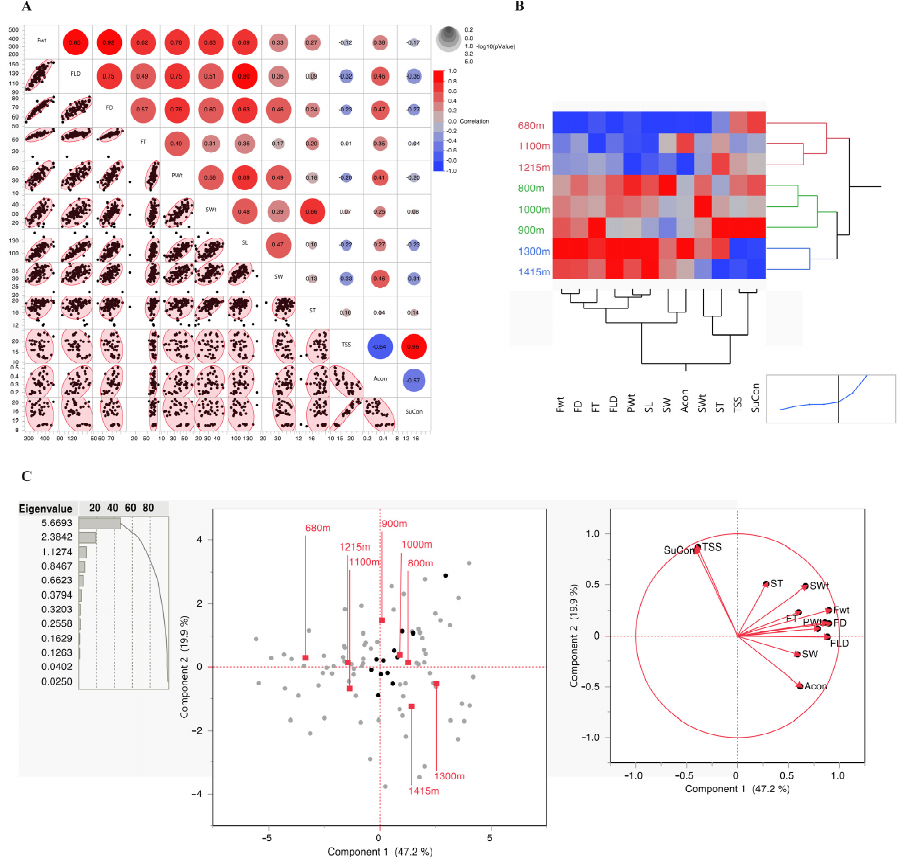
Figure 1. Multivariate analysis of phenotypic and quality traits: ( A ) Pearson’s correlation between all traits. Diagonal is labeled as traits, and on upper triangle shows the pairwise correlation between traits, and the lower triangle shows the distribution of each trait (values of the x axis and y axis are traits values according to which the distribution pattern was estimated); ( B ) Clustering based on phenotypic traits and altitude. The graph in the bottom right corner shows the number of significant clusters based on F -statistics; and ( C ) Principal component analysis depicting the distribution of traits and locations based on the first two components, PC1 and PC2.